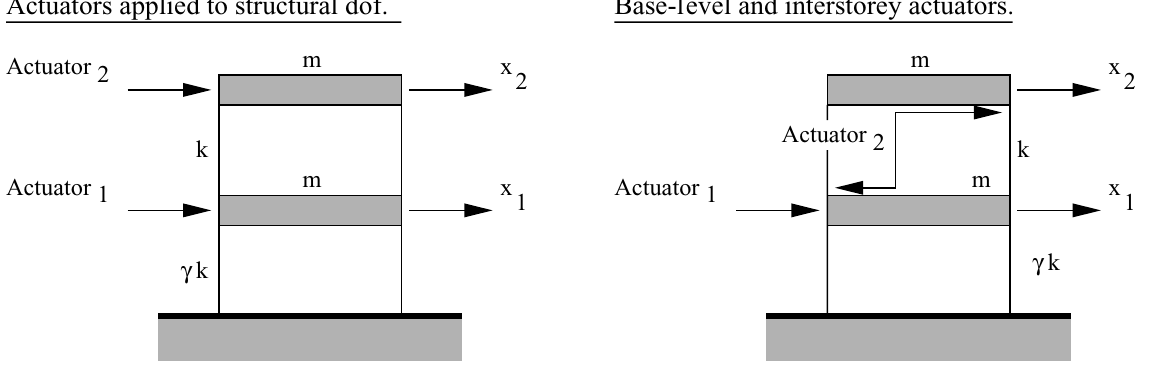
Fig. 1. 2-DOF System Configurations. Left: Actuators applied at the structural degrees of freedom. Right: One actuator is applied to the lower floor dof. A second actuator is applied between the floor